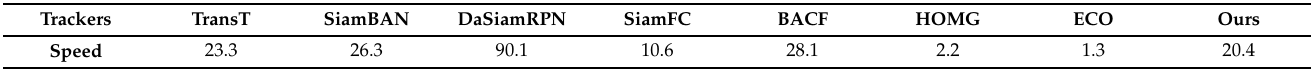
Table 8. Comparison the running time on